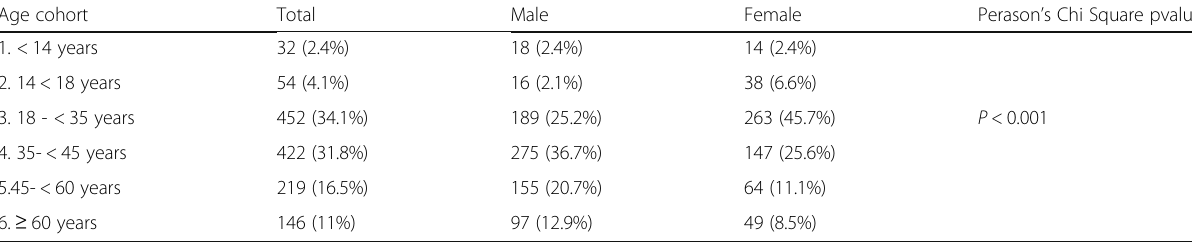
Table 1 Age wise distribution of suicide cases Age cohort